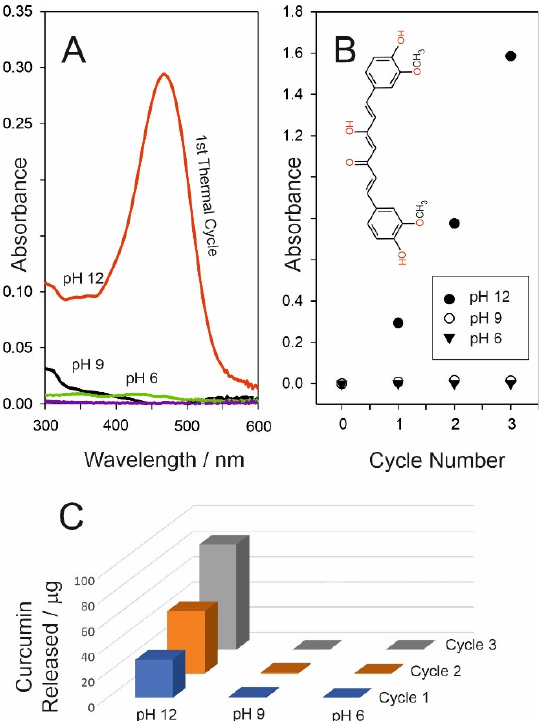
Figure 10. ( A ) UV/vis spectra comparing the influence of pH on the release of curcumin from a wax– curcumin composite film upon heating (3 min). ( B ) Influence of repetitive cycling on the release into buffers of varying pH. ( C ) Comparison of the respective amounts of curcumin released per cycle into the different buffer solutions.